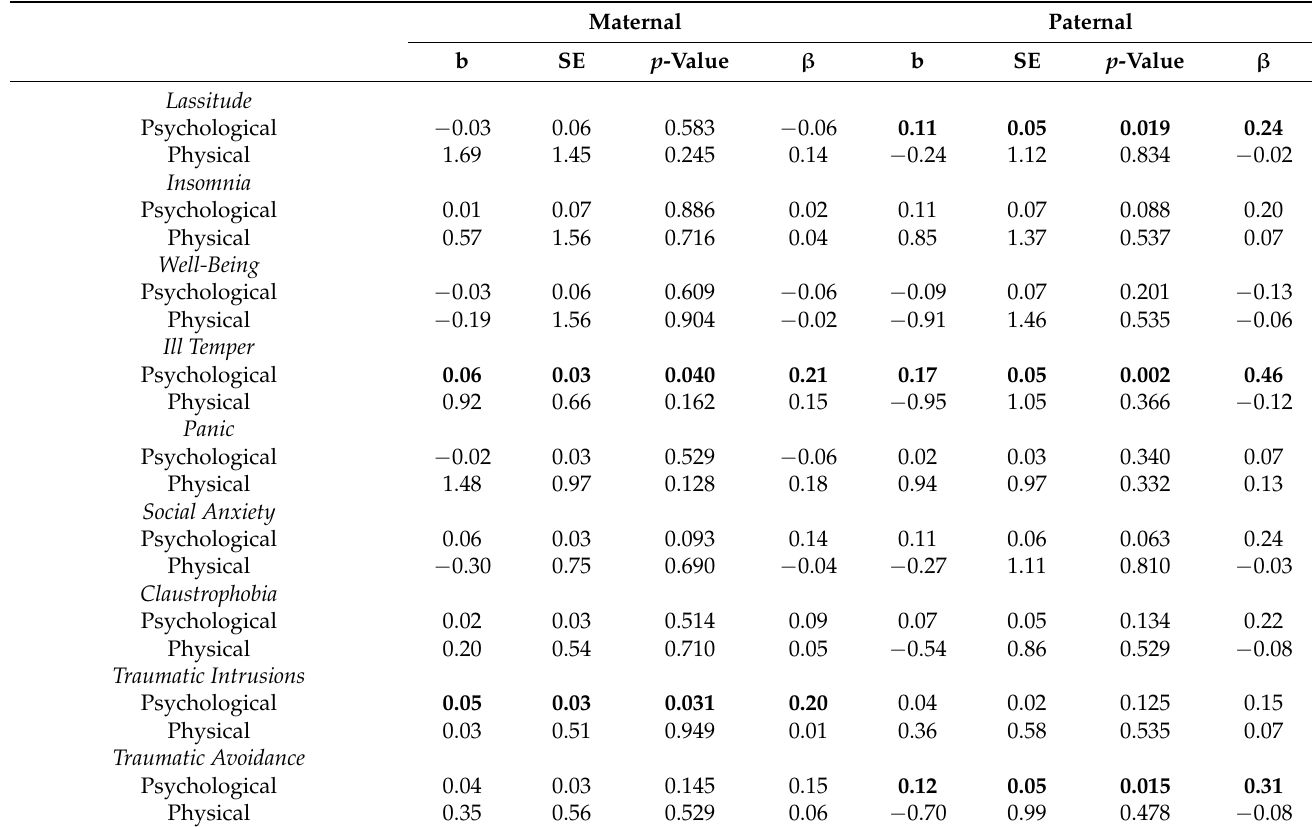
Table 3. Psychological Aggression is Uniquely Associated with Specific Depressive and Anxiety